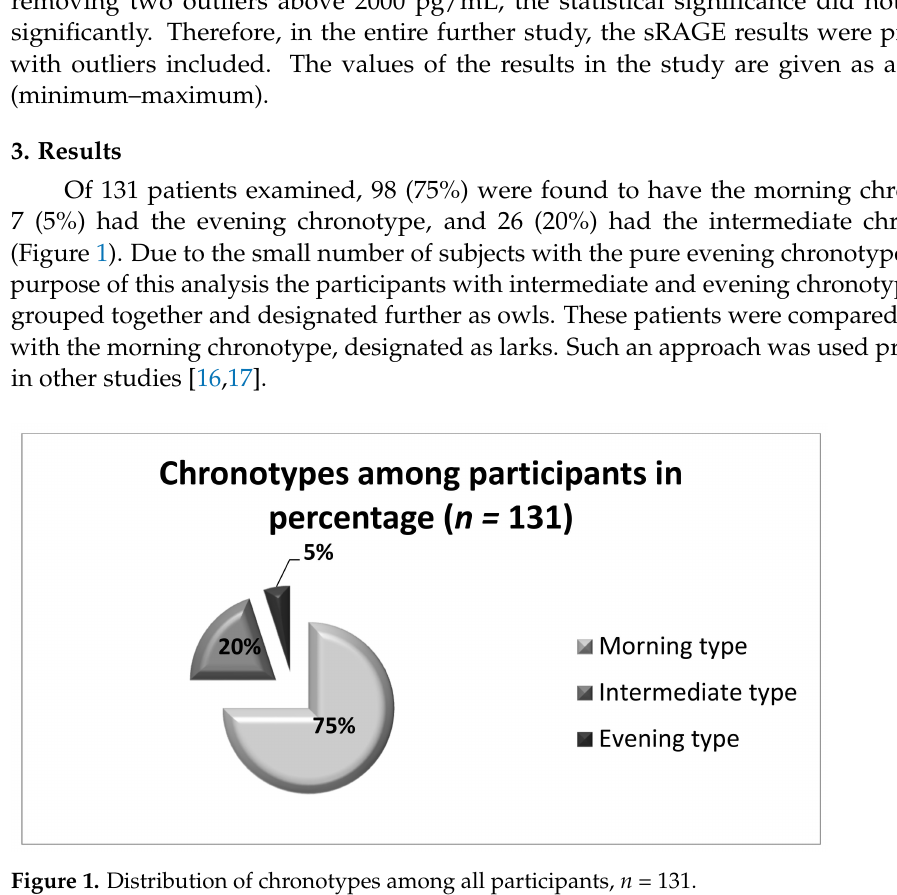
Figure 1. Distribution of chronotypes among all participants, n =